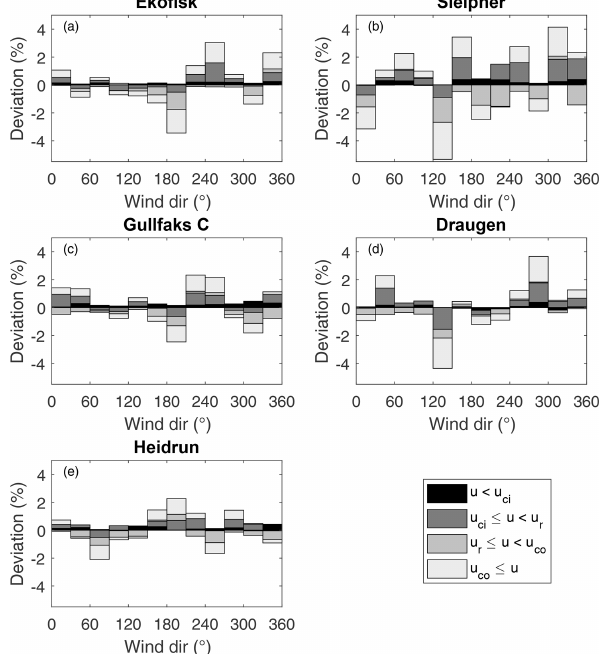
Figure 5. Difference in the occurrence (%) of wind events catego- rized in different wind direction intervals (30 ◦ intervals) between NORA3 and observations (model − obs) for (a) Ekofisk; (b) Sleip- ner; (c) Gullfaks C; (d) Draugen; (e) Heidrun. For each wind di- rection interval the wind events are divided into four different wind speed categories, the first one corresponds to u less than cut-in wind speed ( u < u ci ), the second is the wind speed interval where the wind power is a function of the wind speed cubed ( u ci ≤ u < u r ), the third interval contain the wind speeds corresponding to rated wind power production ( u r ≤ u < u co ), and the last interval is where the wind speeds are too strong resulting in a terminated wind power production ( u co ≤ u ).